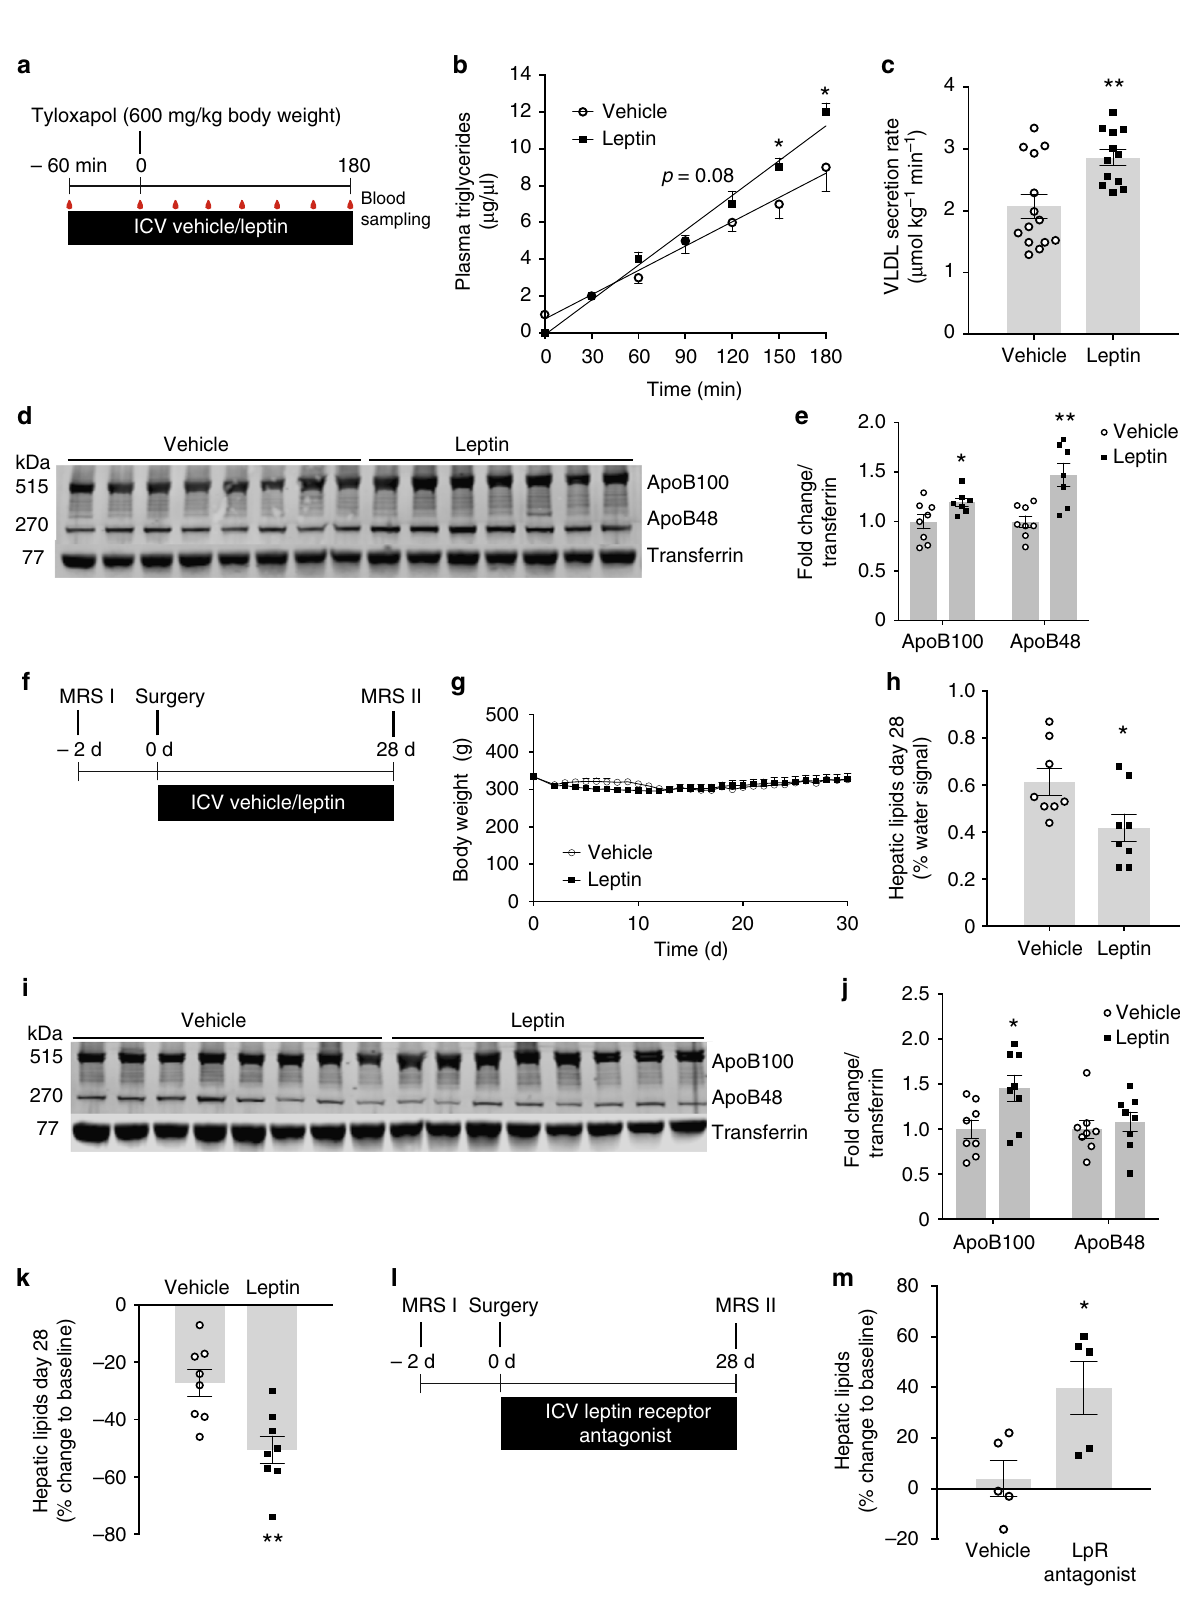
was increased by 20%. Rat hepatocytes also produce ApoB48, (Supplementary Figure 2a), insulin, free fatty acids, free glycerol which was also upregulated after an acute ICV leptin infusion and ketone bodies (Supplementary Table 1), and the rise in the (Fig. 1d, e). The leptin-induced mobilization of TGs occurred VLDL secretion rate during short term (4 h) leptin infusion was independently of differences in plasma levels of glucose not suf fi cient to cause an immediate detectable change in the fi nal NATURE COMMUNICATIONS| (2019) 10:2717